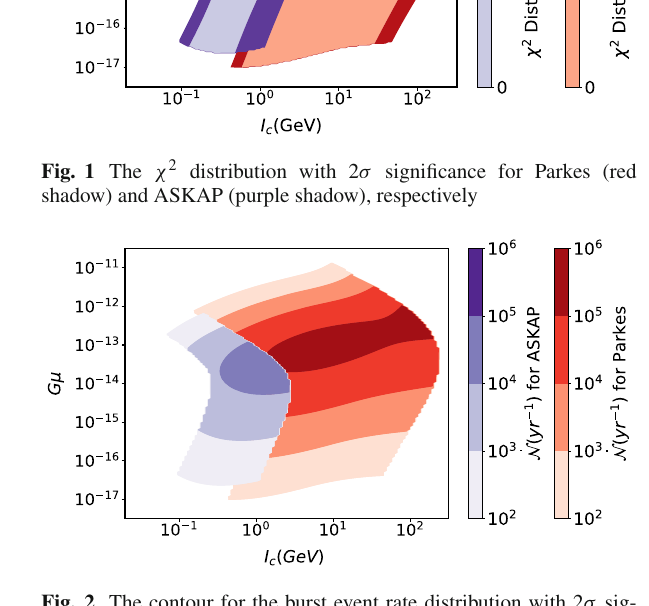
Fig. 2 The contour for the burst event rate distribution with 2 σ sig- nificance for Parkes (red shadow) and ASKAP (purple shadow). The lighter to darker shadows of each color correspond to the regimes with ˙ N ( year − 1 ) from 10 2 to 10 6 ,